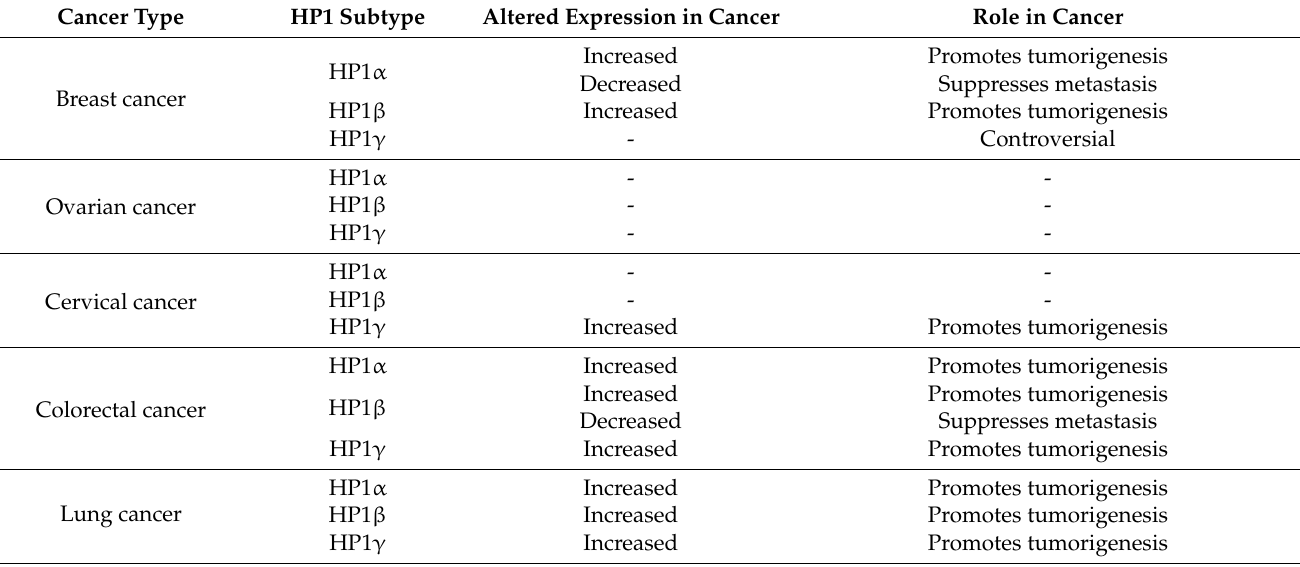
Table 1. Alterations of HP1 expression in